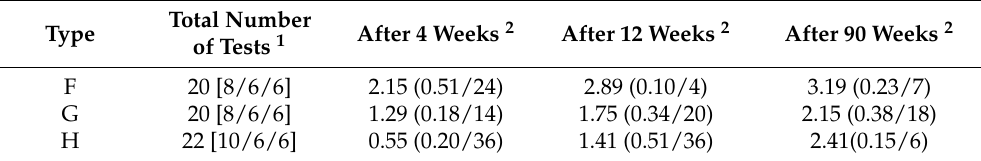
Table 5. Mortar PT strength f m.PT in MPa—an average value from the surface and downhole meas- urements (after deepening the hole with a drill).